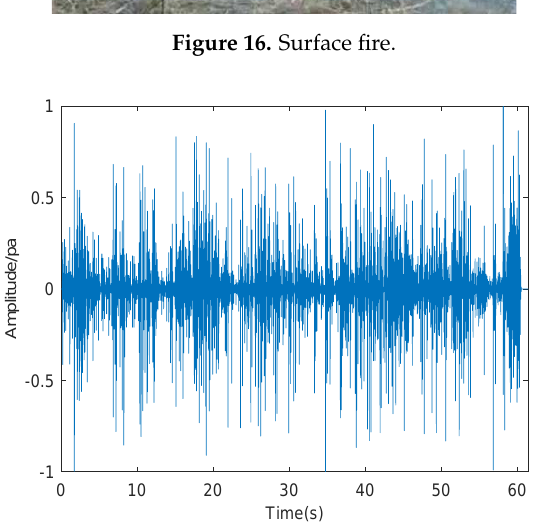
Figure 17. Time-domain sound signal.